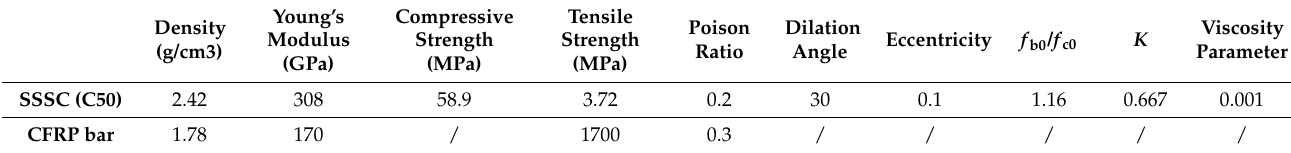
Table 5. Material properties of SSSC cube and CFRP bar.